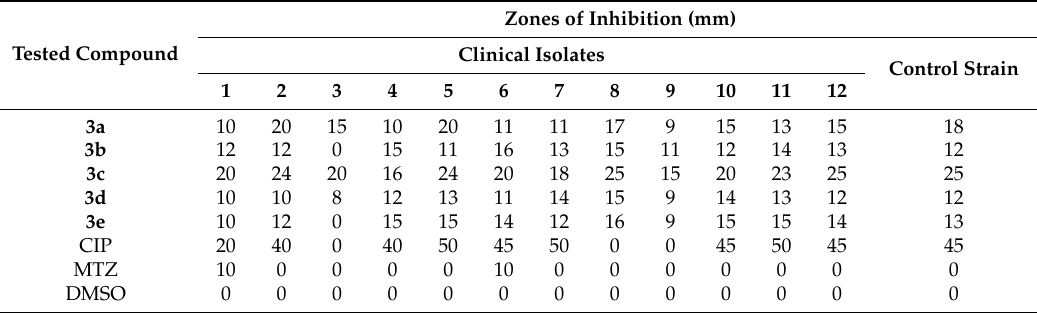
Table 1. Zones of inhibition (mm) of synthesized compounds (1 mg/mL), ciprofloxacin, and metronidazole against clinical strains of H. pylori ( 1 – 12 ) and control strain.